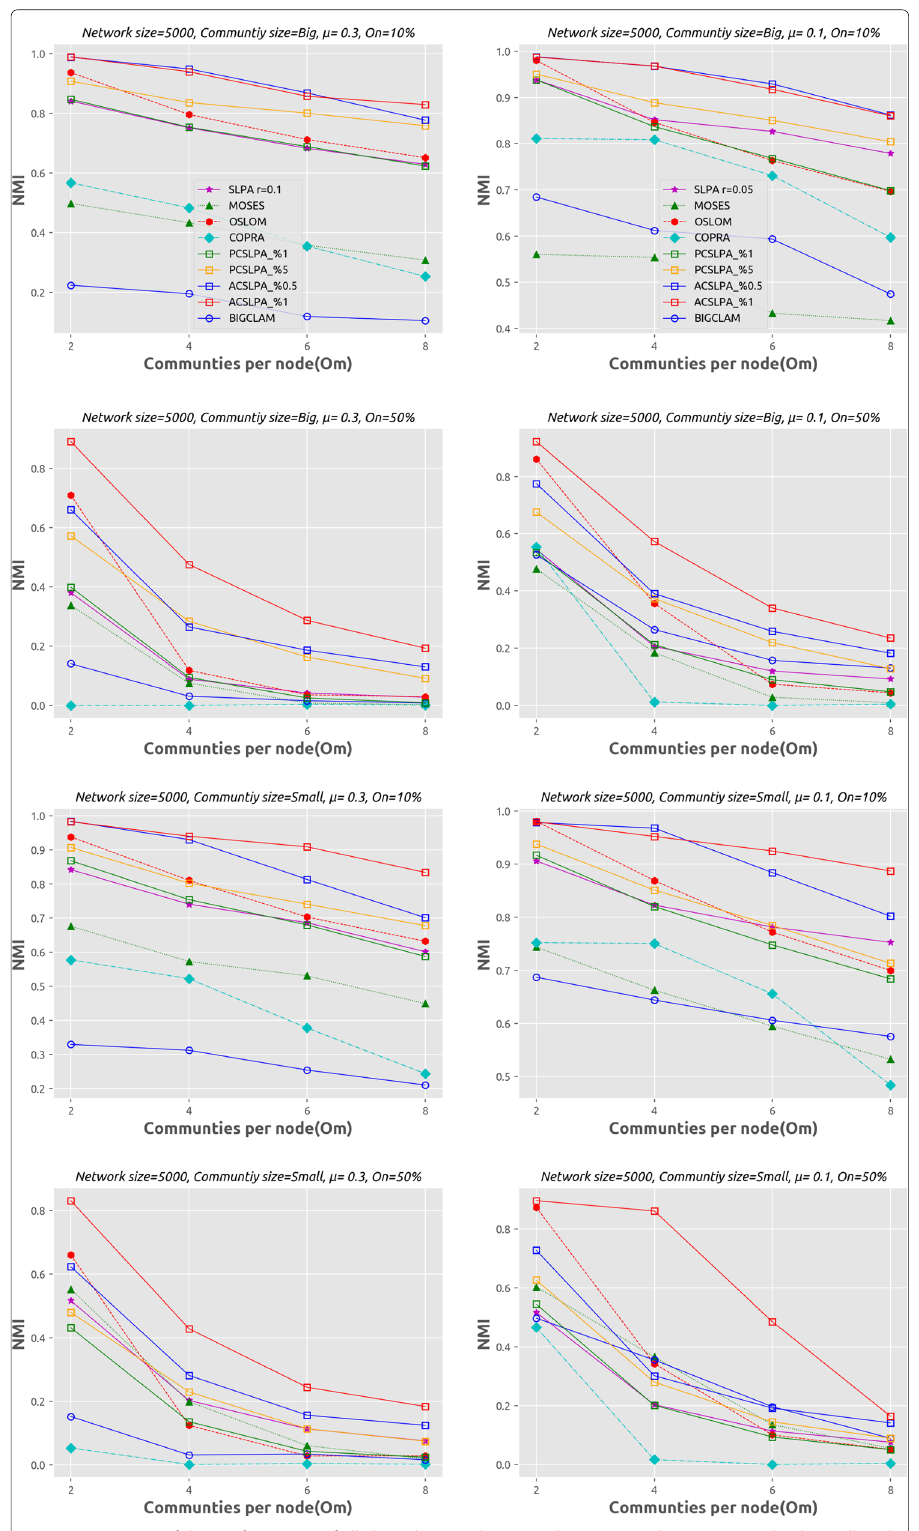
Fig. 5 Summary of the performance of all algorithms on large synthetic networks, containing both small and large communities, where the mixing parameter μ varies from 0.1 to 0.3. NMI values are plotted against the number of communities per node ( O m ) , with 4 networks in each